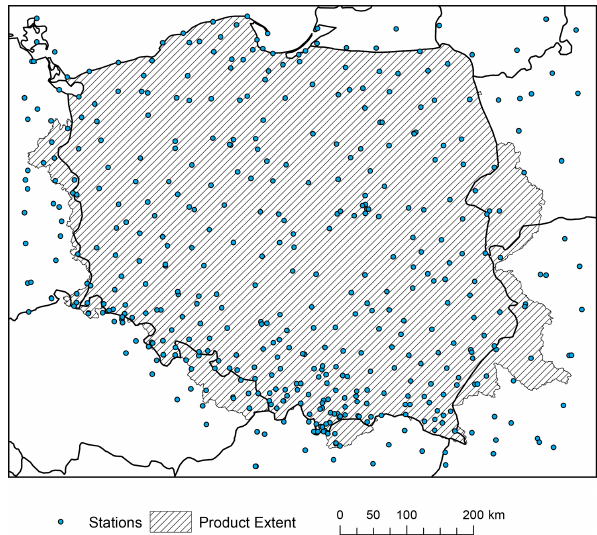
Figure 9. Spatial distribution of wind speed stations used for inter- polation of the G2DC-PL + product.